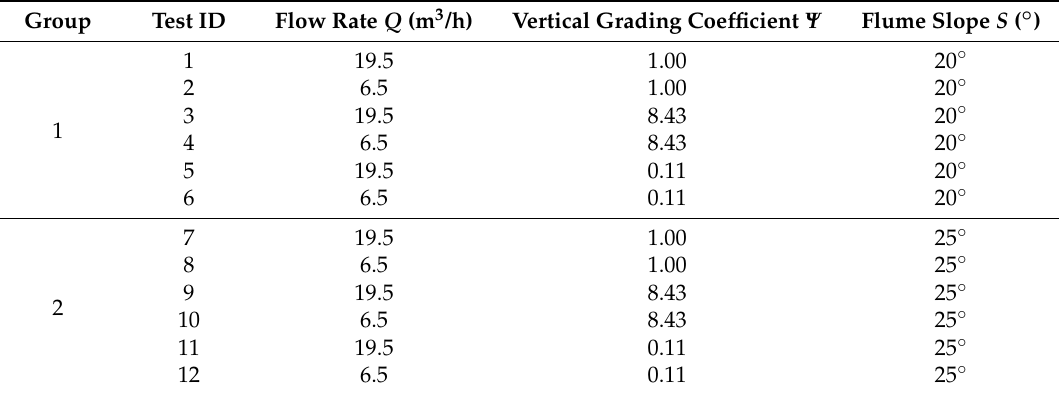
Table 1. Experimental testing